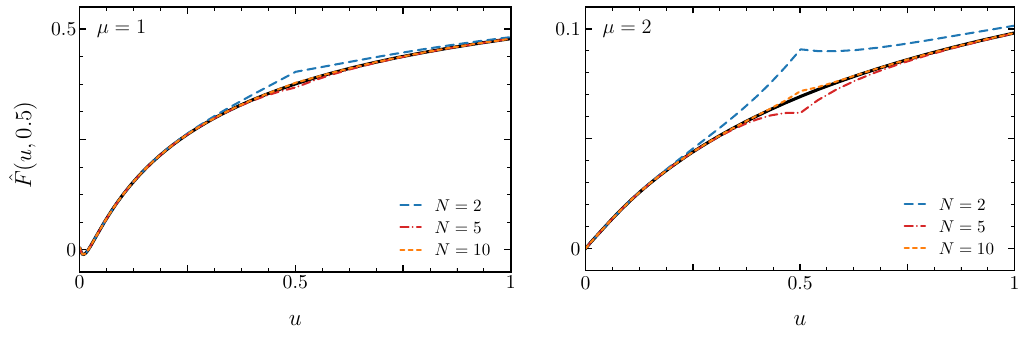
Figure 6. Comparison of the analytic expression for ^ F ( u; v ) keeping only terms from m; n = 0 ; : : : ; N to the numerical solution of the di(cid:11)erential equation (solid black lines). We have chosen v = 0 : 5. The left and right plots are for (cid:22) = 1 and (cid:22) = 2,